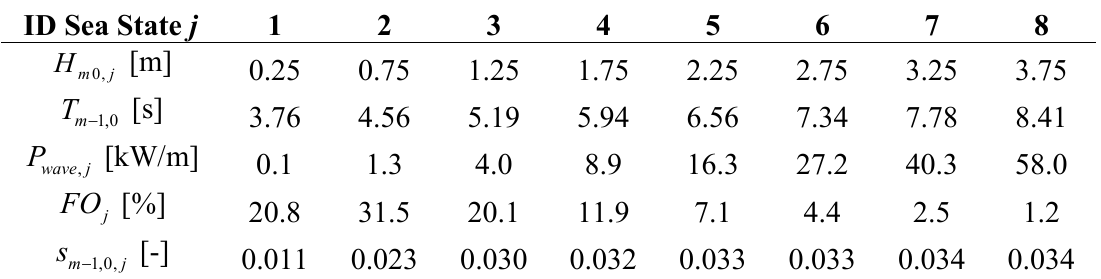
Table 6. Characteristic sea states for location on Danish Continental Shelf (Fjaltring), h = 20 m, source scatter diagram: Ramboll et al. t